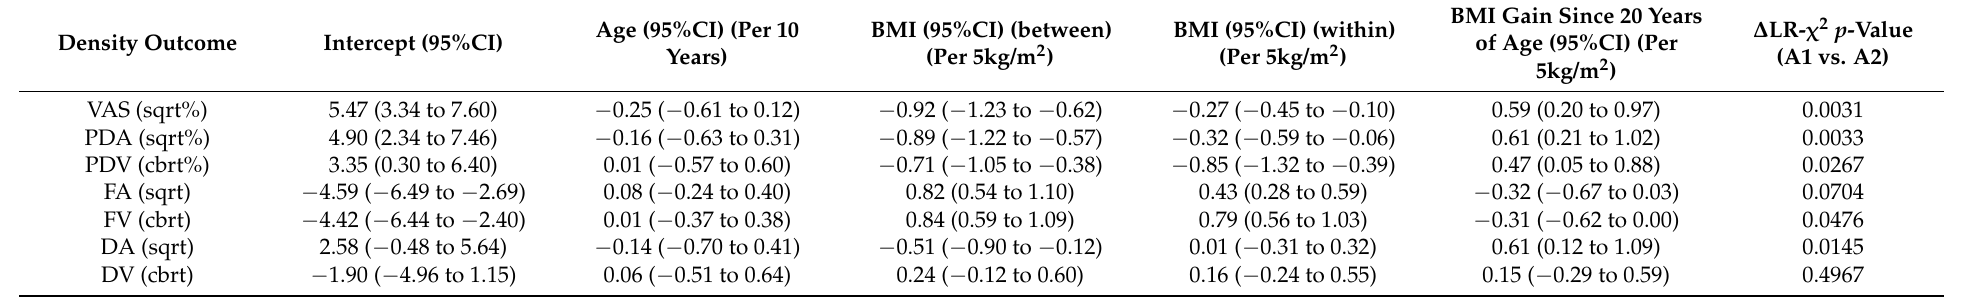
Table 4. Multivariable linear mixed model fit results for mammographic density on body mass index (between and within women) and body mass index gain since 20 years of age, adjusted for age